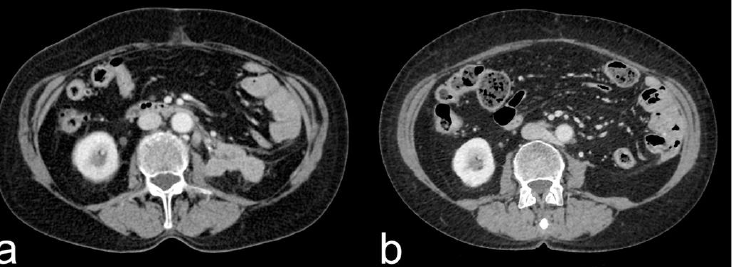
Figure 1. Contrast-enhanced CT axial scan during the venous phase of a nephrectomized 75-year-old female mRCC patient, showing mass-like pathological lymphadenopathies located at the left retroperitoneal space ( a ) and relative CR after ICI treatment, with complete resolution of the mass ( b ).